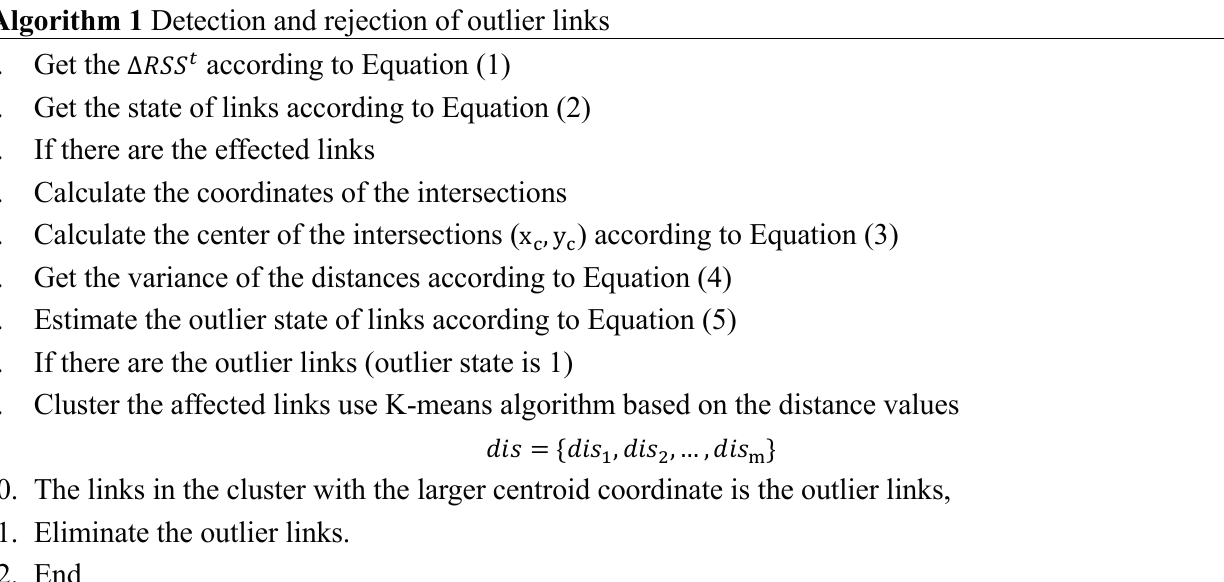
Algorithm 1 Detection and rejection of outlier